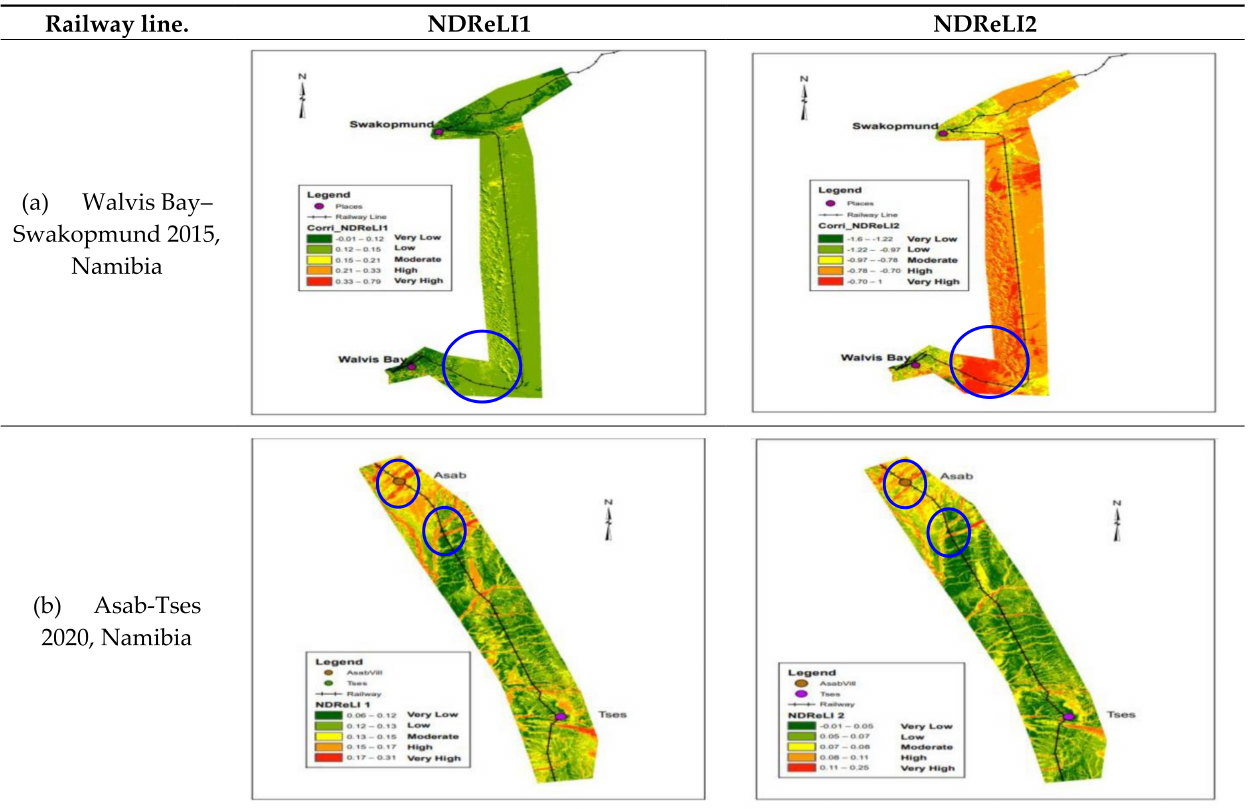
Figure 14. Test results for NDReLI1 and NDReLI2 in Namibia. (The circled areas represent the validation sites within the corridor and only predicted erosion events that run across the railway line are considered as